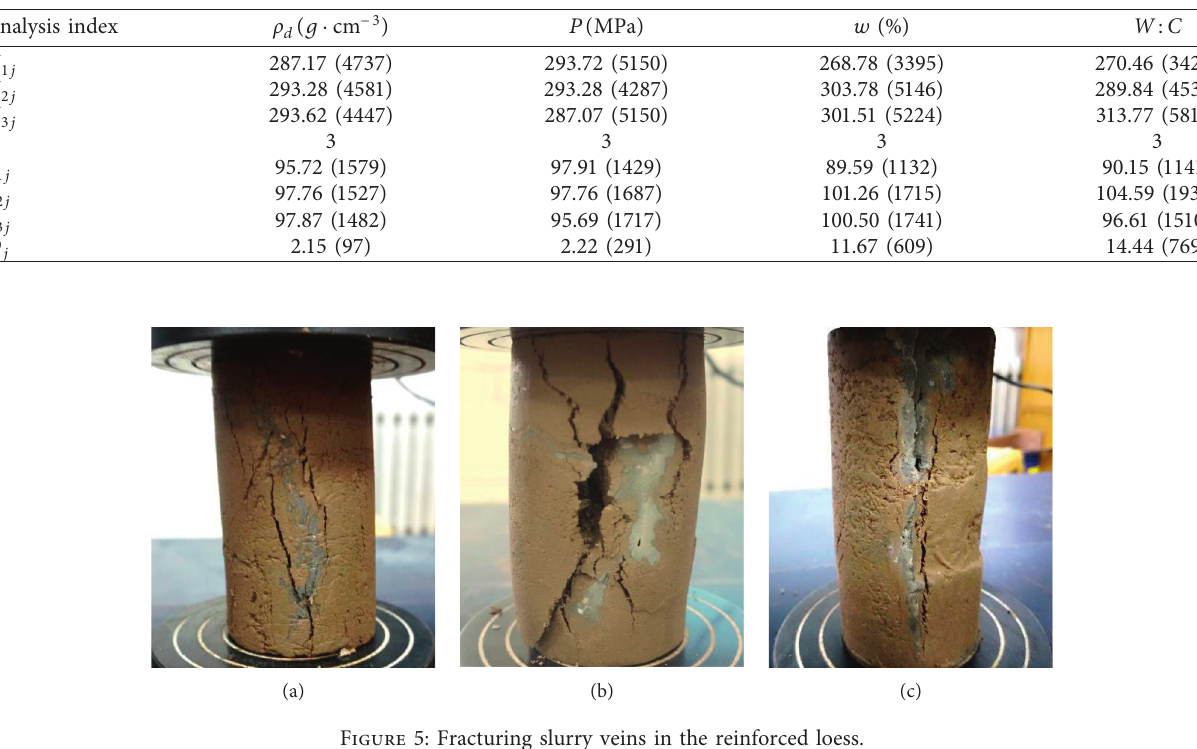
Table 5: Range analysis of cohesion (compressive strength) of reinforced loess.